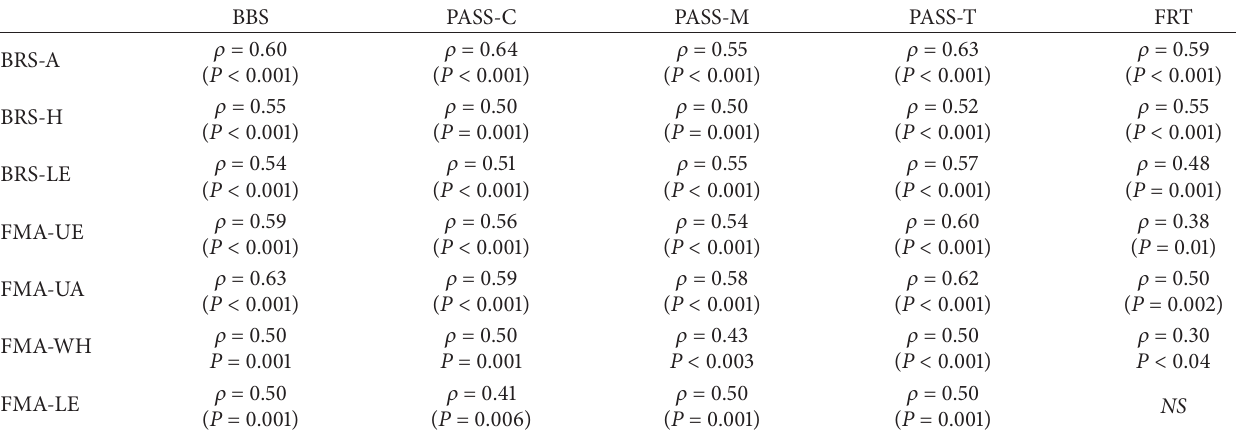
Table 3: Relation between the motor recovery and balance